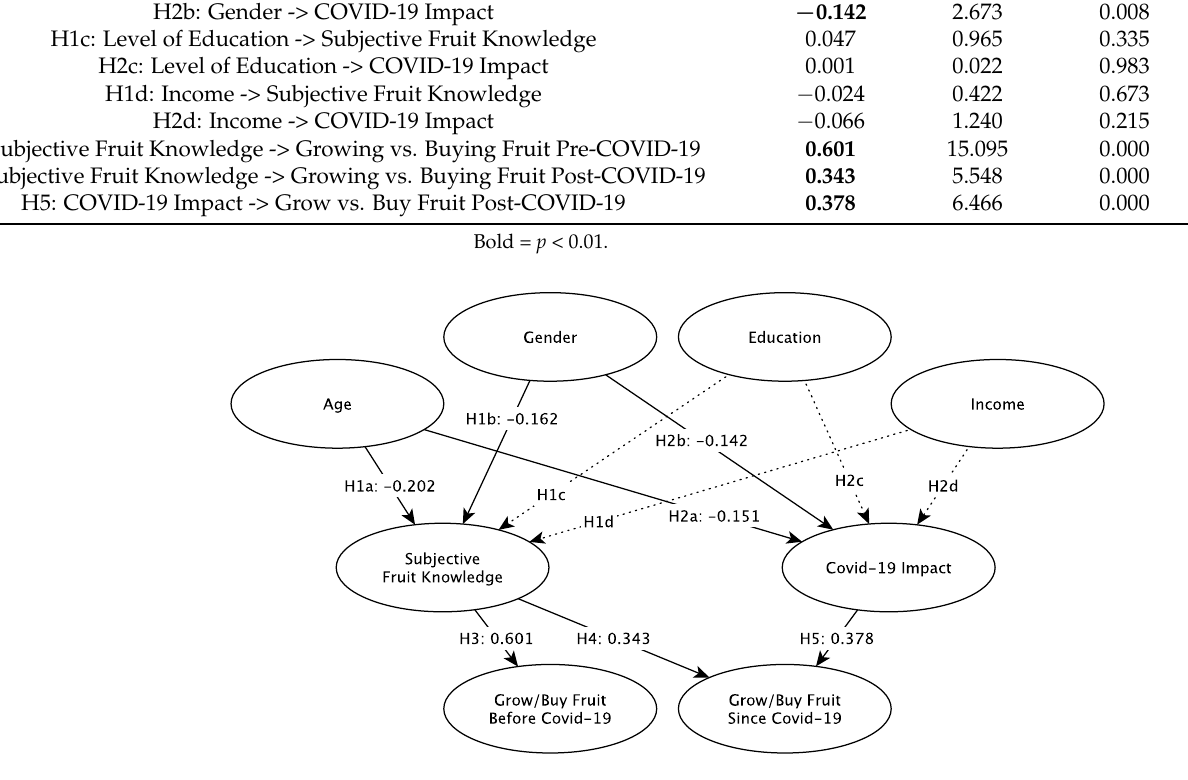
Figure 2. Conceptual Model Results.